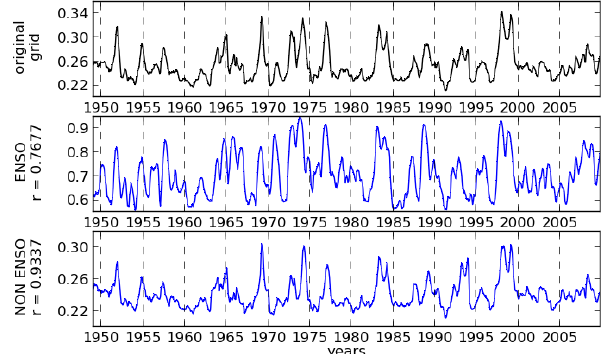
Fig. 8. The temporal evolution of the ENSO and extra-ENSO